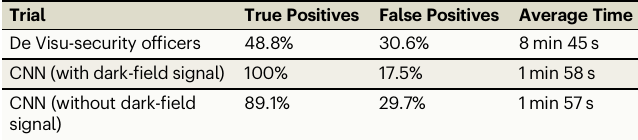
Table 1 | Results from the de visu trials with security of fi cers, and from the CNN